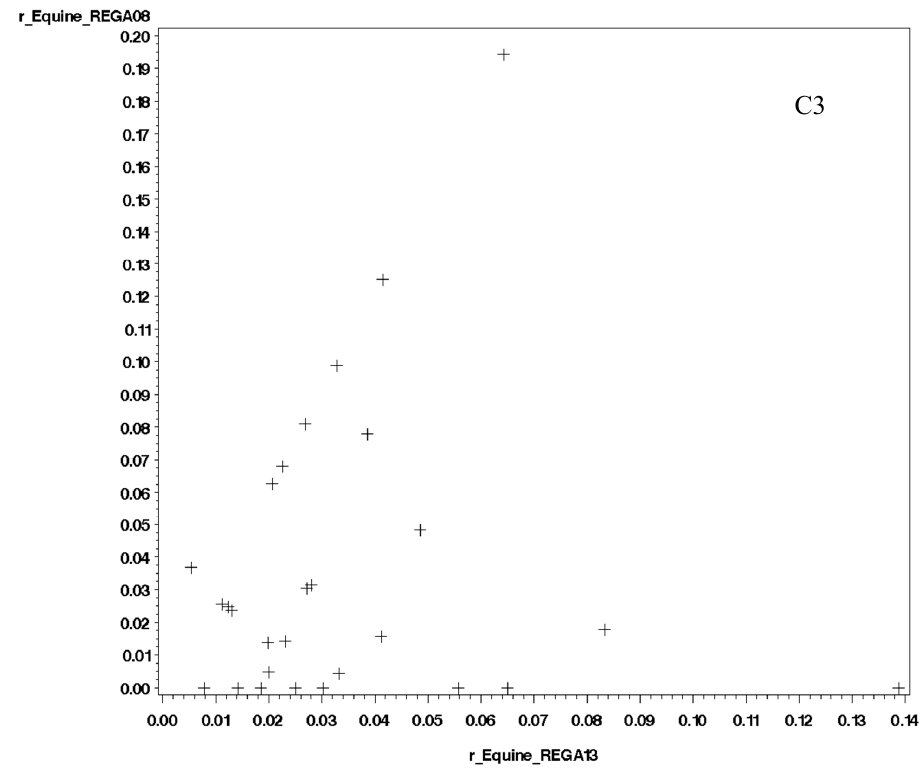
Figure A3. Scatter plots of relative number of heads for equine (C1–C3).